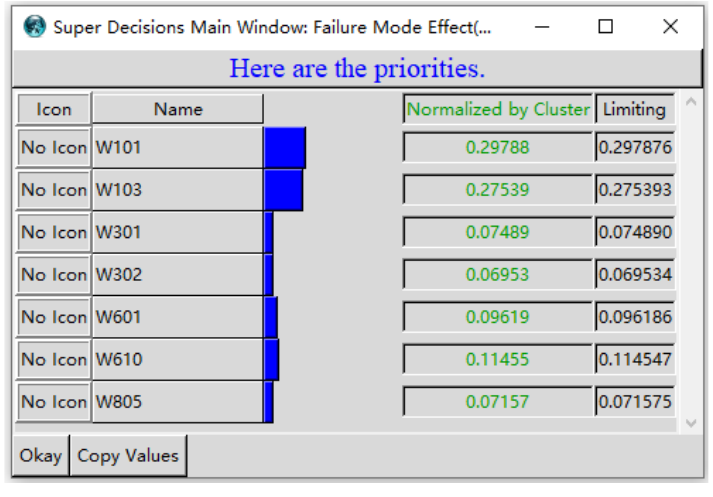
Table 7. Frequency ratio of failure modes and influence degree of failure modes of each component of machining center. Code Pattern Code